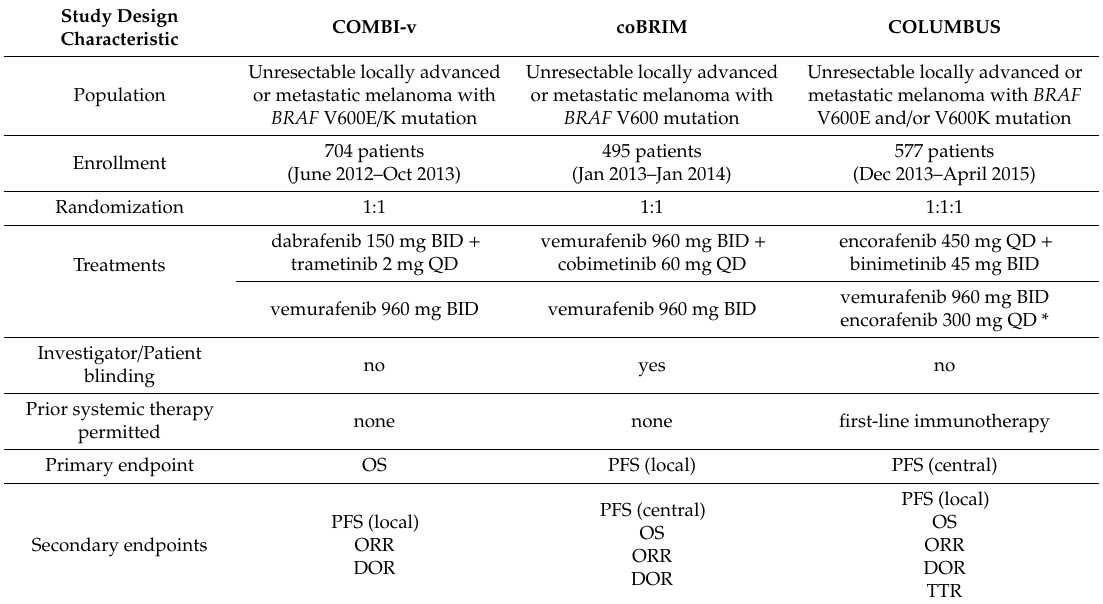
Table 5. Overview of study designs for the COMBI-v, coBRIM, and COLUMBUS trials [9,10,23]. Study Design